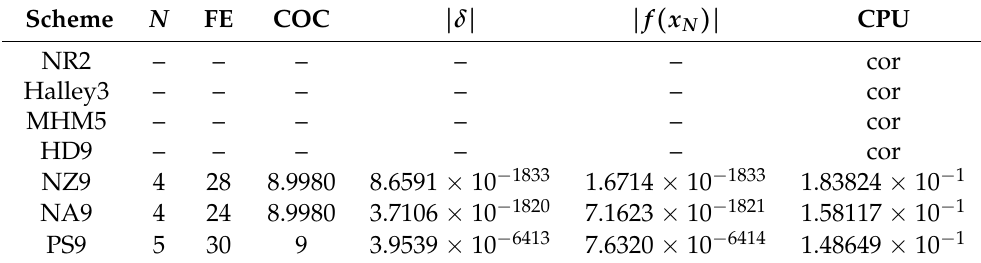
Table 9. Numerical results for the problem 4 with initial guess x 0 = 1.5 m.